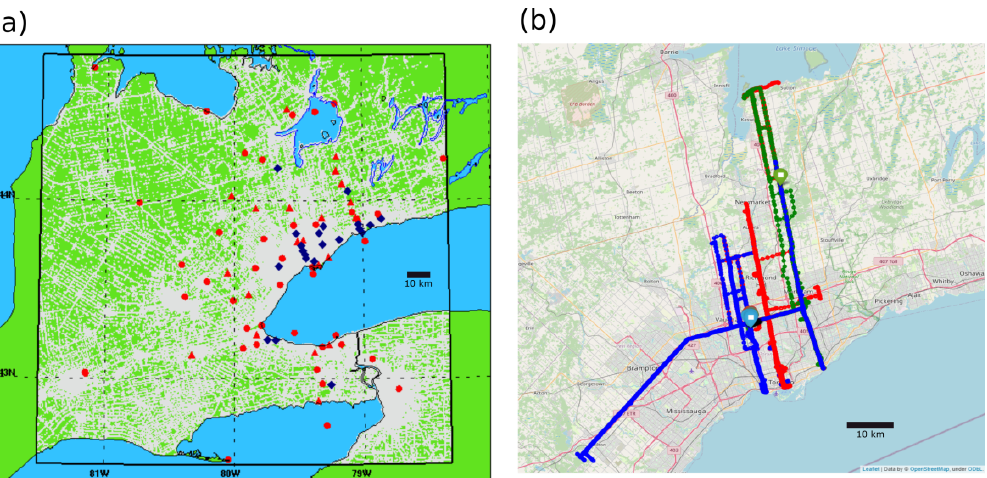
Figure 4. ( a ) Geographical location of fixed stations (ECCC PanAm and regular ECCC stations) over the 250-m computational domain. Rooftop stations (blue diamond) and ground stations (red, including stations with wind measured at 10 m, circles, and at 2.5 m, triangles). Clear areas are for the urbanized grid points. ( b ) Overview of AMMOS mobile routes (followed by 3 different cars identified by blue, red or green color) superimposed with geographical map